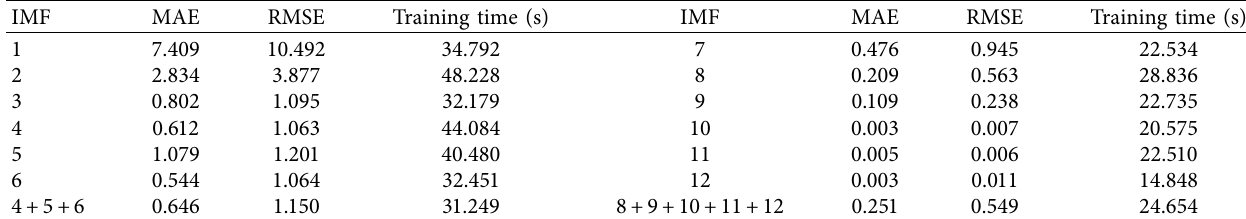
Table 4: Prediction error and training time of TCN in different IMF of 717490.